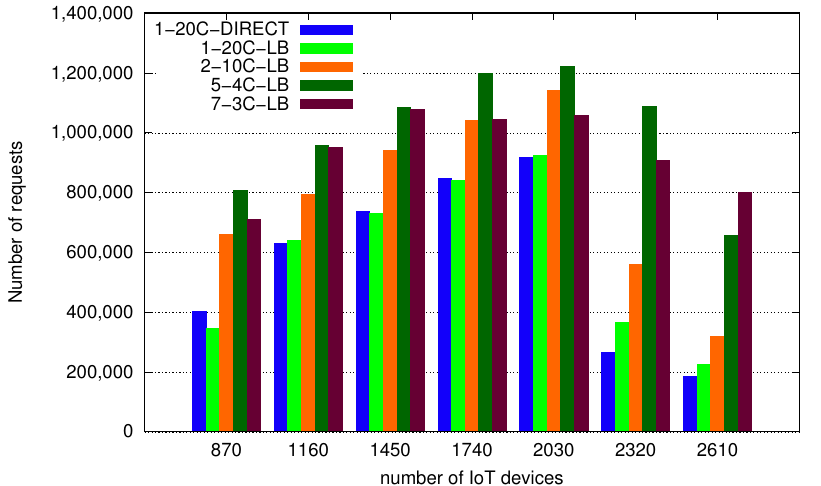
Figure 11. Number of successfully processed